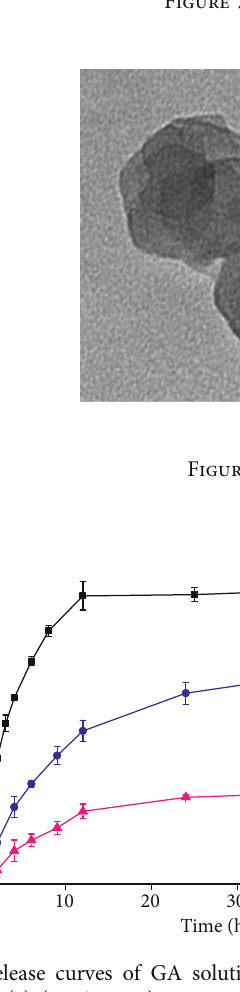
Figure 7: Zeta potential of GA-LDH/LS (a) and GA-LDH (b) ( n = 3 , x ± s ).